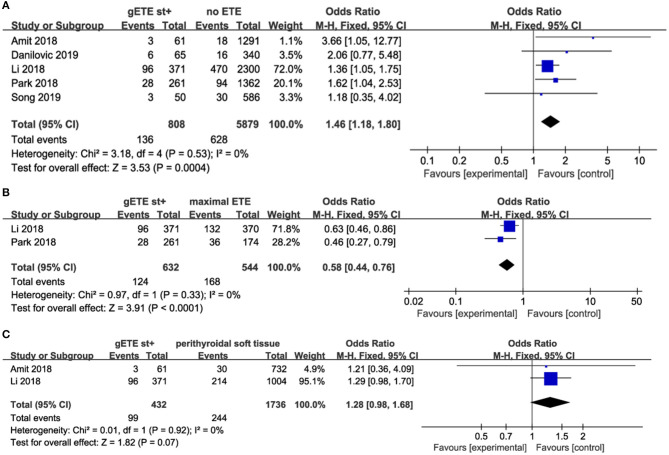
Forest plot for LRR comparison between gETE st+ with (A) no ETE (B) maximal ETE (C) perithyroidal soft tissue.